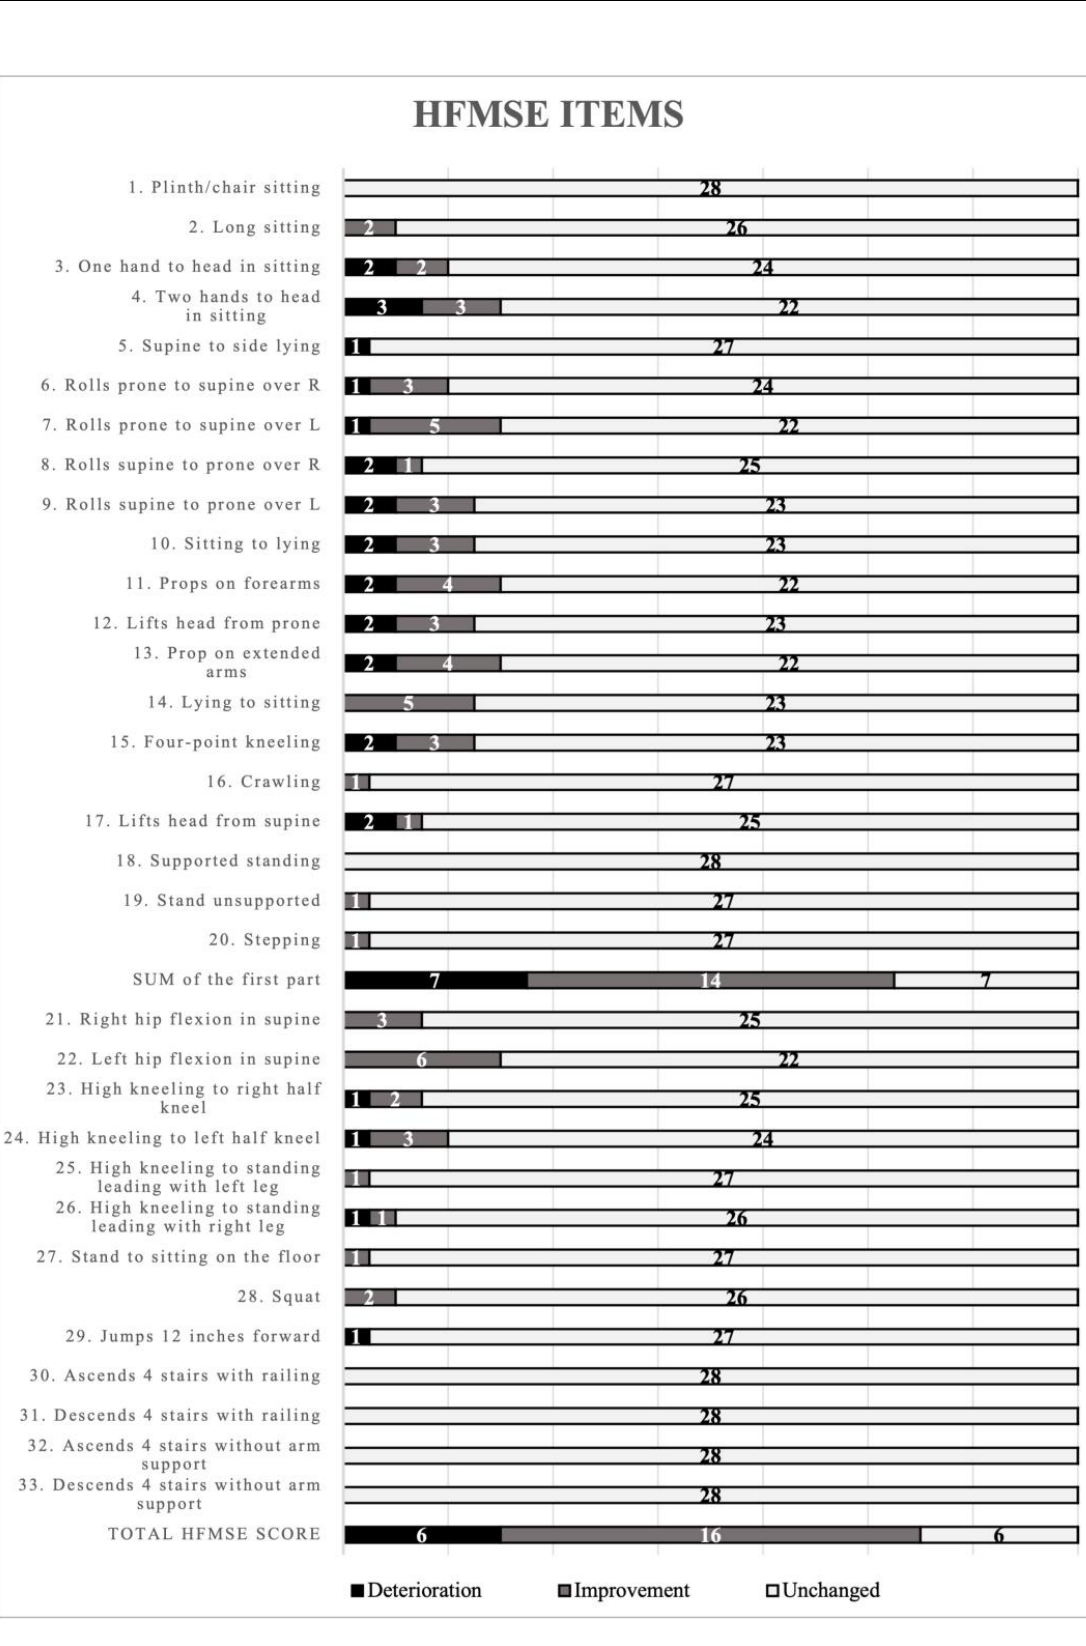
Figure 2. Number of children with deterioration, improvement or unchanged in individual HFMSE scale items .